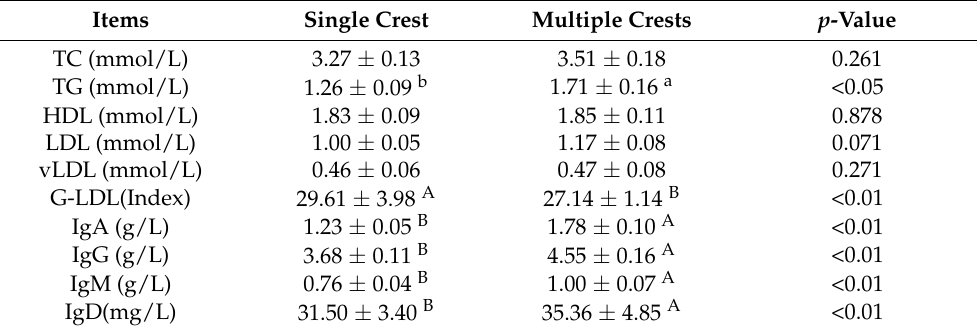
Table 6. Effect of crested cushion on lipoprotein and immunoglobulin in serum biochemical parame- ters.